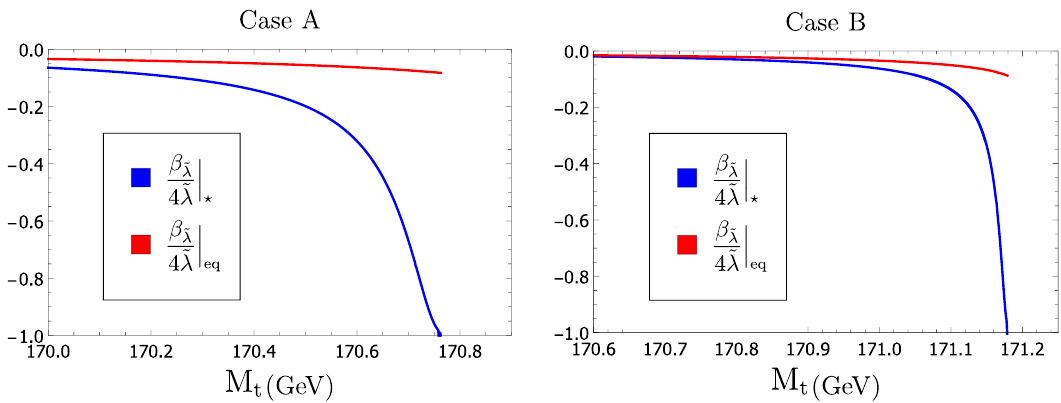
Figure 3 . The value of ( (cid:12) ~ = ~ (cid:21) ) eq (red curves) depends only on the SM couplings at the EW scale (cid:21) and on the running (no threshold corrections are included). Its value translates in the actual size of the RG correction (blue curves) through the enhancement given in eq. (5.16). For ( (cid:12) ~ the potential cannot sustain 60 e -folds of in(cid:13)ation anymore. In case B, due to the gauge boson contributions, the absolute value of the correction takes almost a step function shape. This causes a smaller region in parameter space with respect to case A for which the predictions are sensitive to the RG